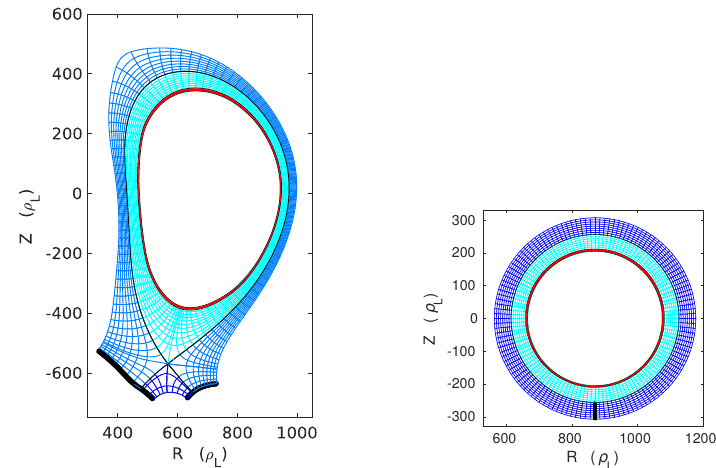
Figure 2. ( Left ) COMPASS-like mesh grid used for TOKAM3X simulations. Displayed grid is coarser than the actual used by the code by a factor four, both in radial and poloidal direction. Toroidally, a quarter of the torus is simulated. Thick black line indicates divertor targets, where the Bohm’s boundary conditions are imposed. The region where the particle source is located, is highlighted in red. ( Right ) same plot for the limiter